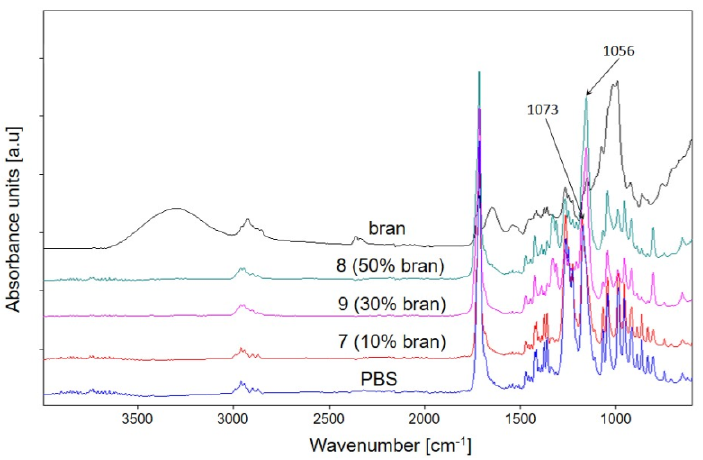
Figure 9. ATR-FTIR spectra of PBS, bran, and their composites 7, 8, 9 obtained with different bran content.